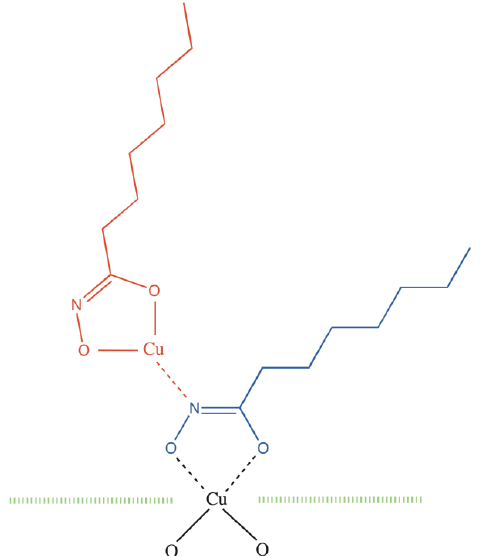
Figure 1. Schematic representation of n -octanohydroximate (blue) chemisorbed to a Cu atom in a Cu oxide surface (green) and interacting with a Cu hydroximate molecule